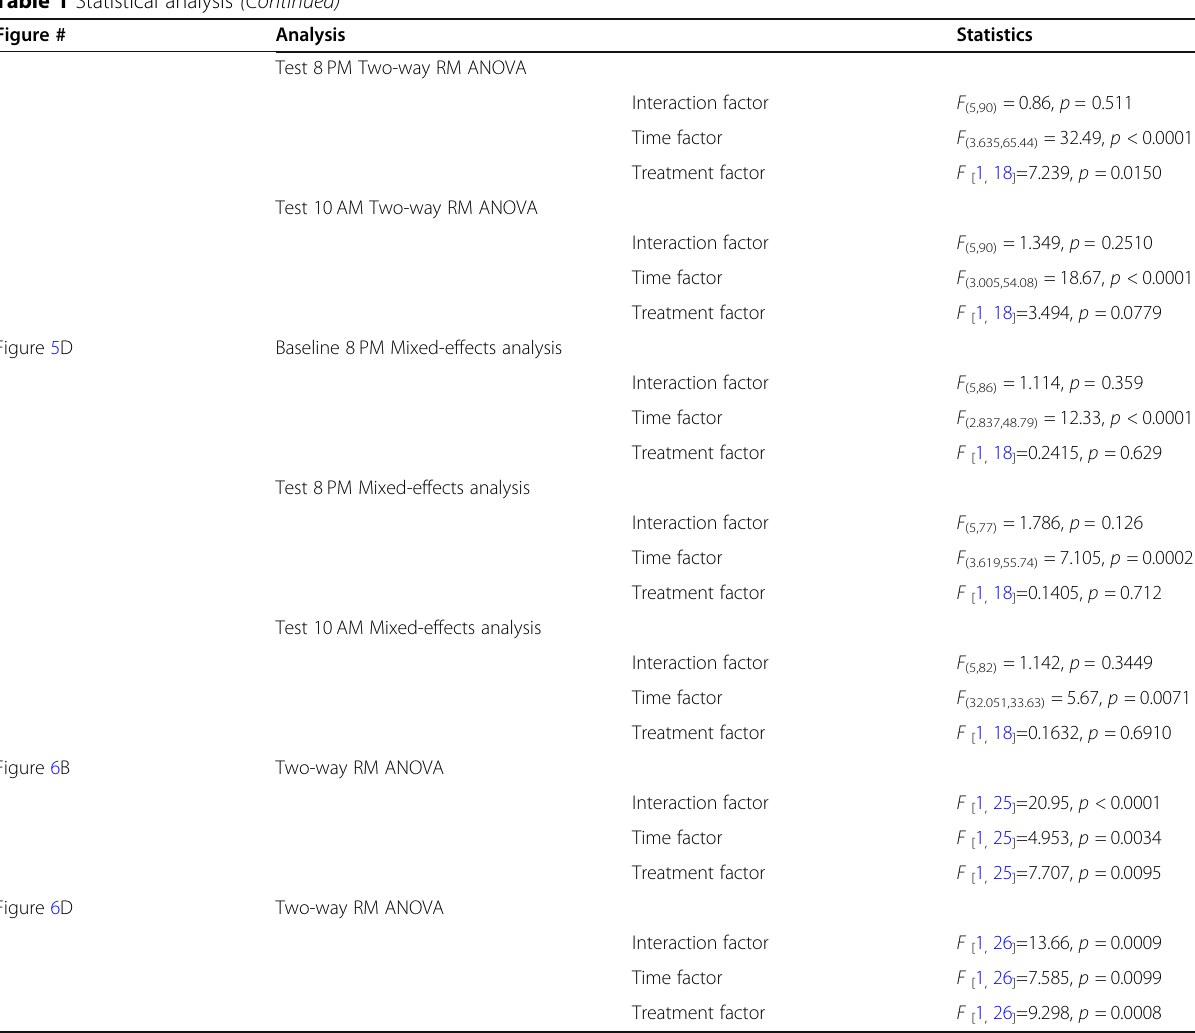
Baseline 8 PM Mixed-effects